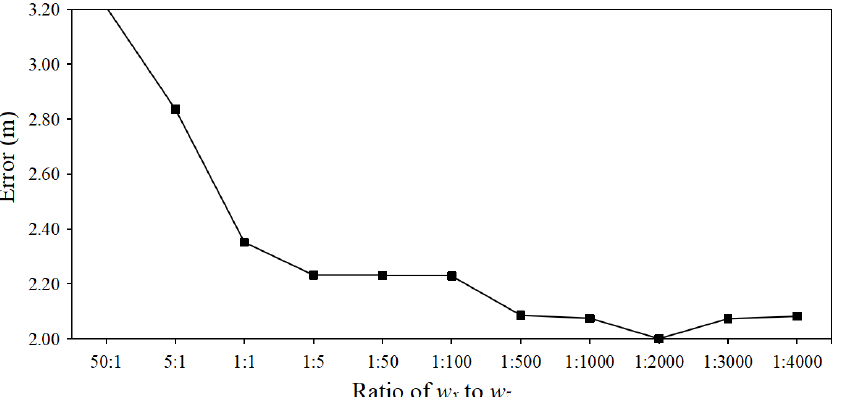
 to  . Figure 18. The curve of error and ratio of ω X to ω Z X Z